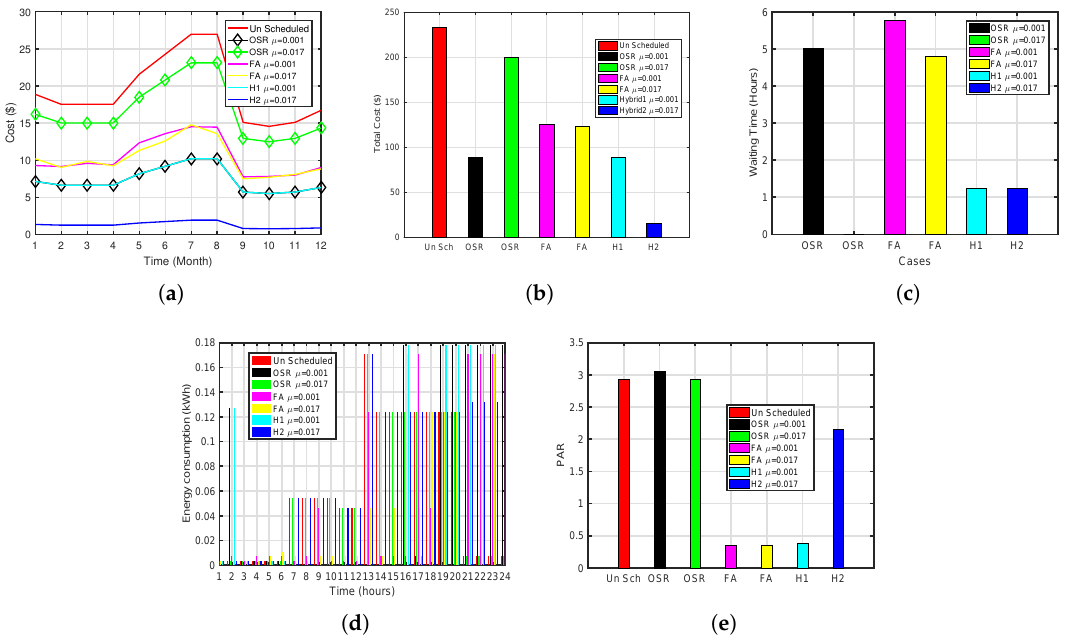
Figure 11. Hybrid Plots for Dish Washer (OSR-FA). ( a ) Monthly Cost of Dish Washer (OSR-FA), ( b ) Total Cost of Dish Washer (OSR-FA), ( c ) Waiting Time of Dish Washer (OSR-FA), ( d ) Energy Consumption of Dish Washer (OSR-FA), ( e ) PAR of Dish Washer